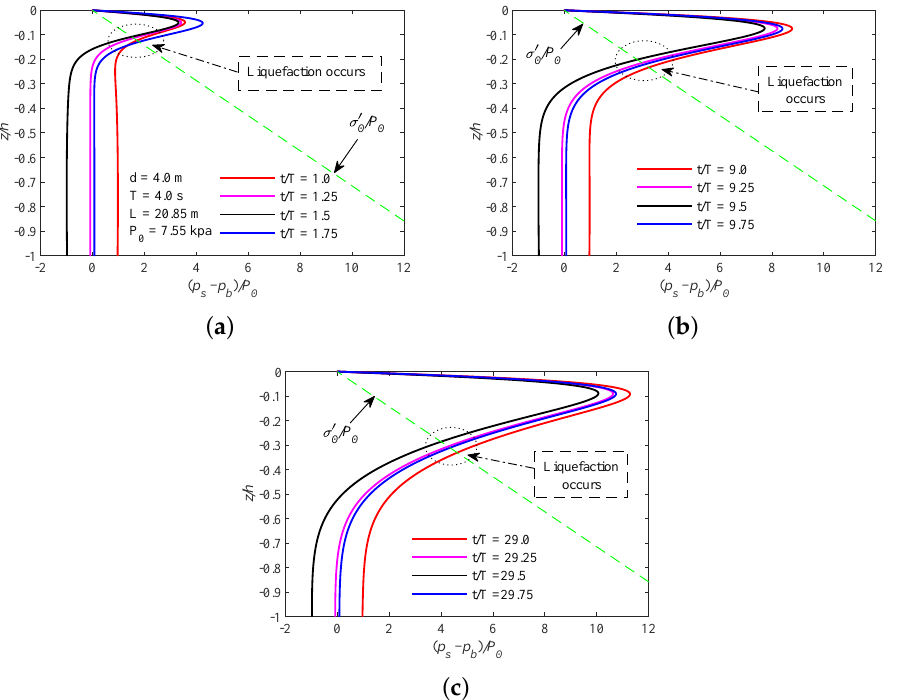
Figure 11. The cumulative-dominant liquefaction potential (Case 2); ( a ) In the 2nd wave cycle; ( b ) In the 10th wave cycle; ( c ) In the 30th wave cycle.